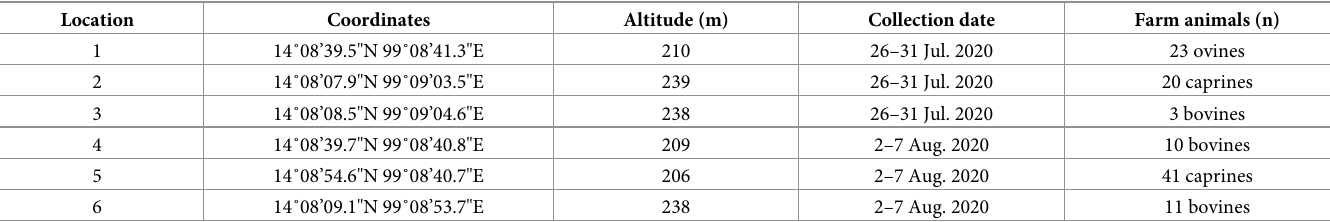
Table 1. Description and collection data from six Culicoides sampling locations in Sai Yok District, Kanchanaburi Province, Thailand.